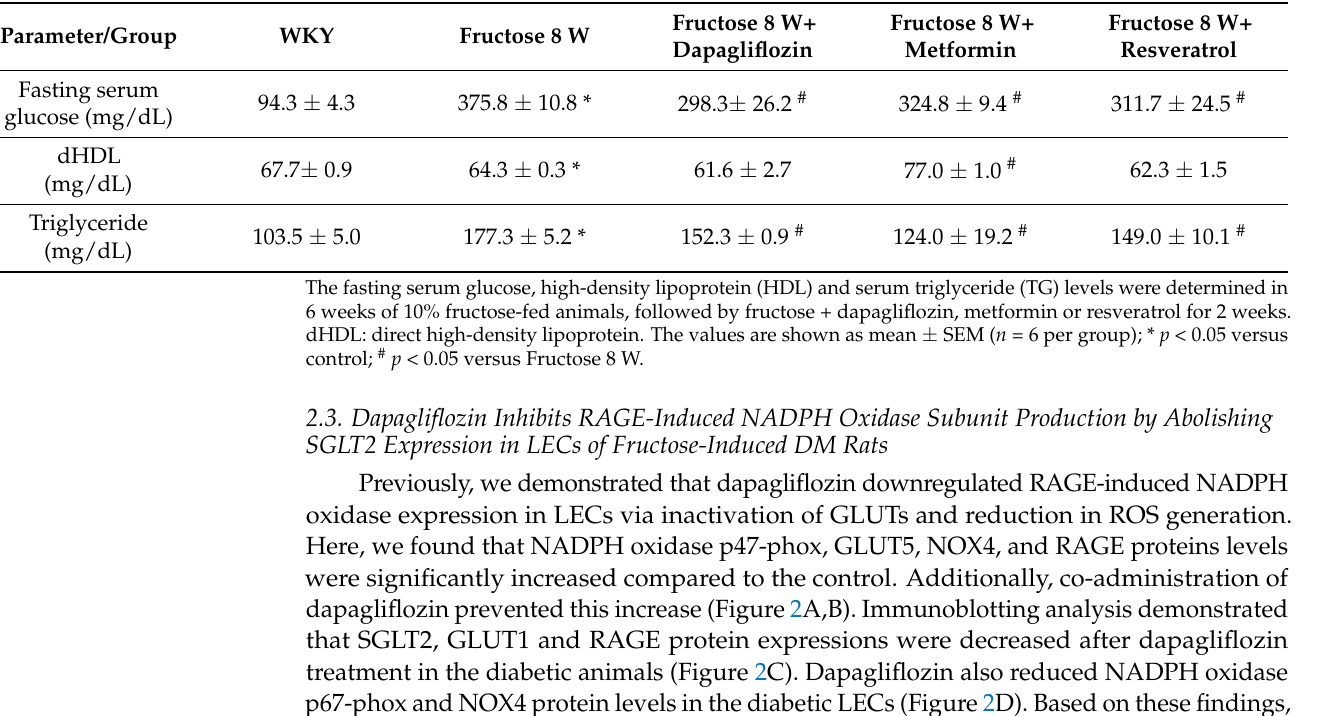
Table 2. General characteristics of the experimental groups.